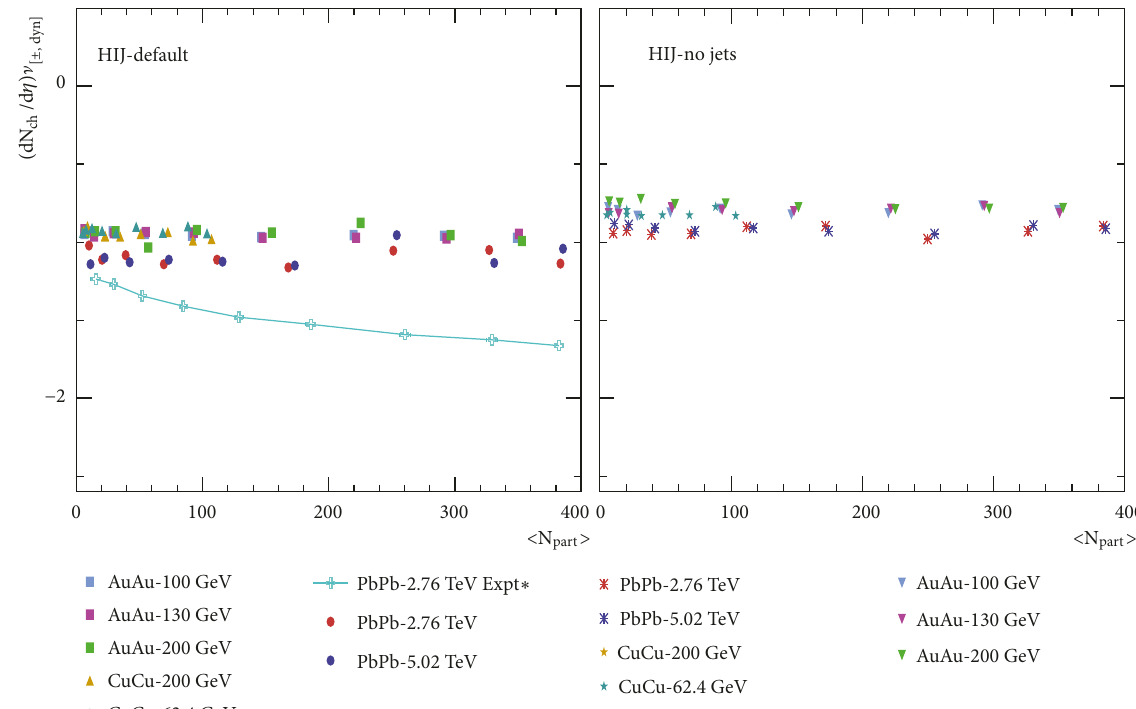
Figure 3: (𝑑𝑁 𝑐ℎ /𝑑𝜂) ] [+−,𝑑𝑦𝑛] plotted against 𝑁 𝑝𝑎𝑟𝑡 for HIJING default with jet production on (left panel) and jet production off (right panel). The line represents the Pb-Pb data from